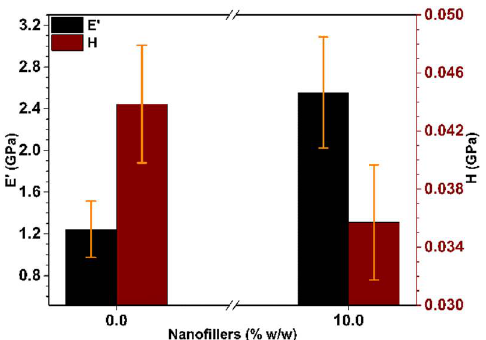
( d ) Figure 7. Contour maps of mechanical properties variation in the measurements of (cid:1831) (cid:4593) ( a , b ) and (cid:1834) ( c , d ), obtained on a surface area of 120 μm × 150 μm in the substrates manufactured of resin without Cu NWs ( a , c ) and with Cu NWs at 10.0% (cid:1875) (cid:1875)⁄ ( b , d ), respectively. Figure 8 presents the average values of E’ and H for the pure resin and for the one loaded with the 10.0% (cid:1875) (cid:1875)⁄ Cu NW solutions. The increase in storage modulus when loading the resin with Cu NWs can be once again attributed to the load transfer while the decrease in hardness could be due to the decrease of the density related to the evaporation of IPA during the UV curing of the resin. Accordingly, if globally averaged properties are required for a polymeric or composite matrix